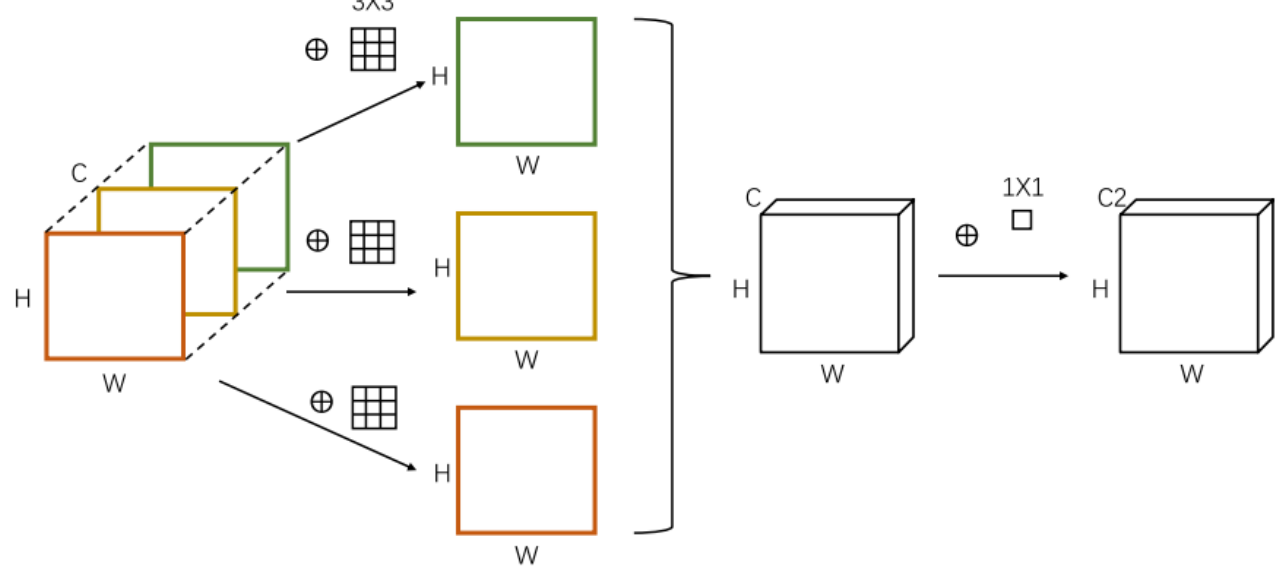
Figure 7. A structure of depthwise separable convolution neural network.